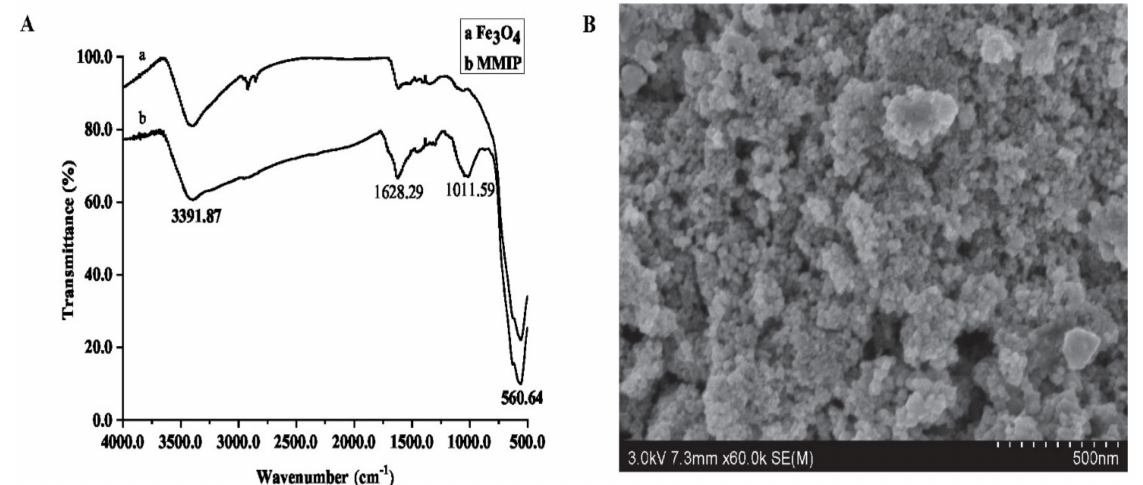
Figure 2. The characteristics of MMIP (( A ). FTIR; ( B ).